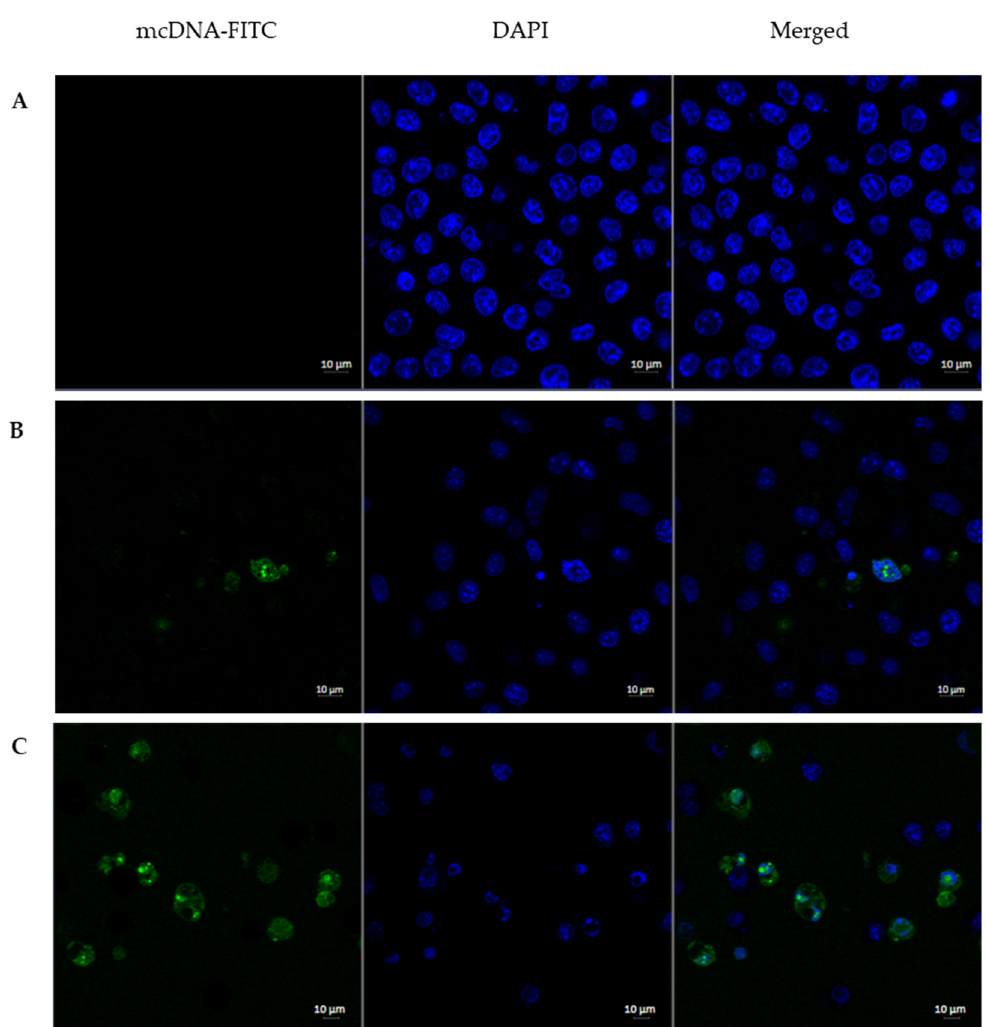
Figure 8. The transfection ability and intracellular co-localization of PEI/mcDNA (N/P ratio of 5:1) and R8-mannose/PEI/mcDNA (N/P ratio of 2:5:1) systems was investigated by fluorescence confocal microscopy. Nuclei were stained blue by DAPI, while green represents the mcDNA stained with FITC. Live cell images: Raw 264.7 non-transfected cells ( A ); Raw 264.7 cells after 3 h of transfection with PEI/mcDNA (N/P ratio of 5:1) system ( B ) and Raw 264.7 cells after 3 h of transfection with R8-mannose/PEI/mcDNA (N/P ratio of 2:5:1) system ( C ).